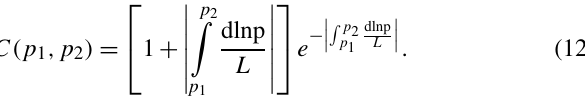
Figure 3c is the 12:00 UTC, 28 July 2007 NAAPS AOD product from the natural run. In comparison, Fig. 3d shows the same situation, this time with the use of OMI AI data as- similation. Comparing Fig. 3b and d, dust and smoke aerosol patterns as shown from OMI AI more closely resemble the NAAPS AOD fields after AI assimilation. Over the north- east coast of Africa, heavy aerosol plumes, as hinted at in NAAPS AOD from the natural run (Fig. 3c), cover larger spatial areas than those inferred from OMI AI data. In com- parison, NAAPS AOD patterns from the OMI AI data